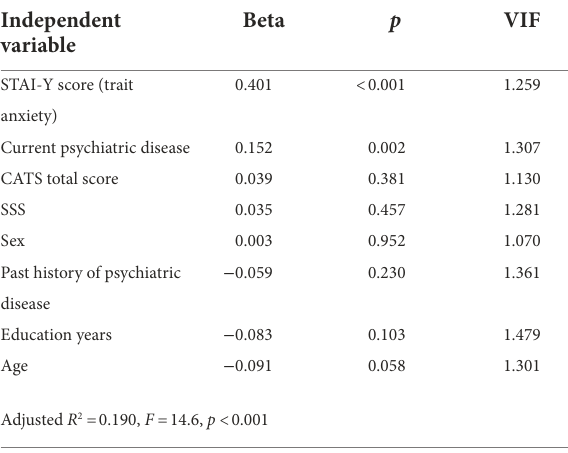
TABLE 2 Results of multiple regression analysis with WLQ %productivity loss score as the dependent variable. Independent variable